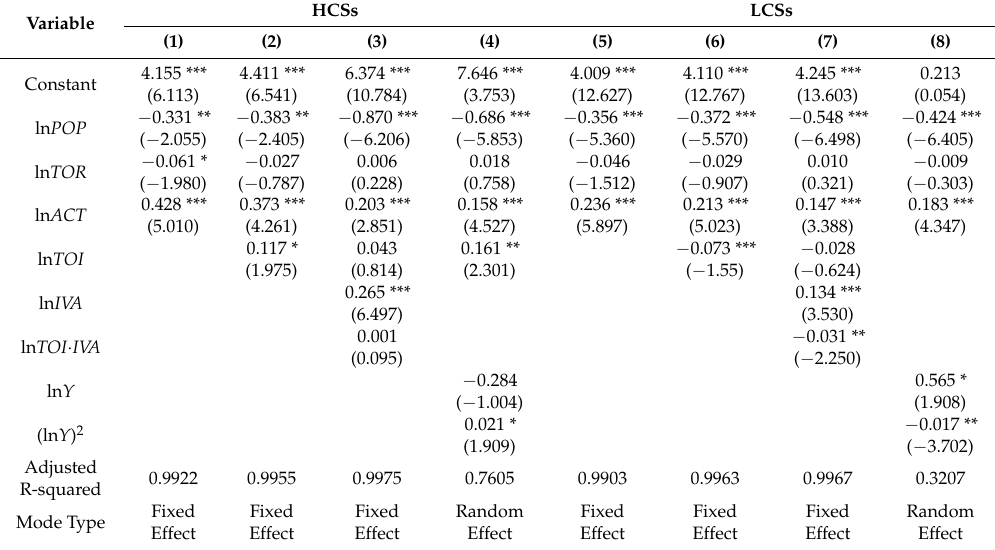
Table 3. Regression analysis of CO 2 emissions’ intensity in HCSs and